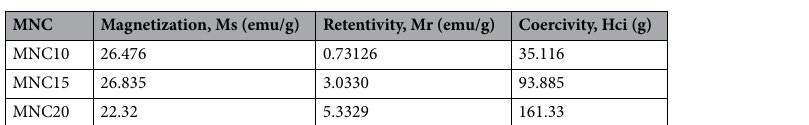
Table 2. VSM parameters for different MNC.